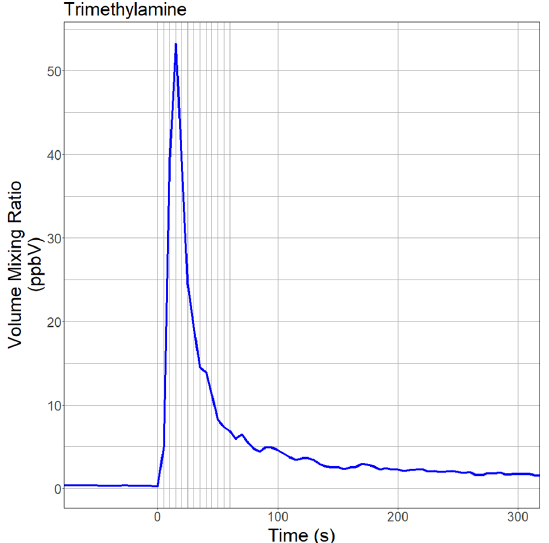
Figure 2. Time series of trimethylamine as measured in labora- tory air when a Chenopodium vulvaria L. plant was mechanically stressed by tipping a leaf with a